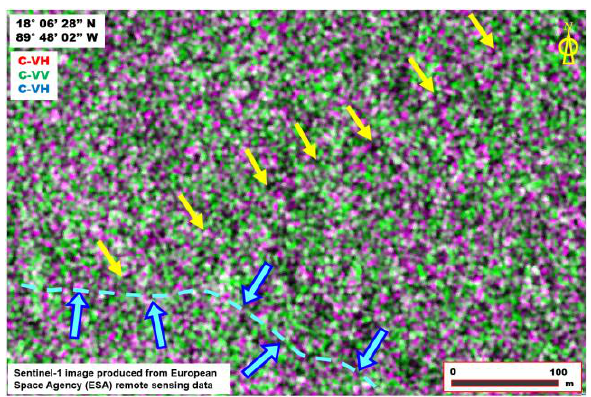
Figure 12. Comparison between an access road (blue arrows) and the nearby sacbe segment #3 (yellow arrows) of Folan et al. (1995) located in a forested area on a false-colour composite made with the Sentinel-1A image acquired in May 2016, with the C-VH image in red and blue, and the C-VV image in green. The location of the sacbe is indicated by yellow arrows.